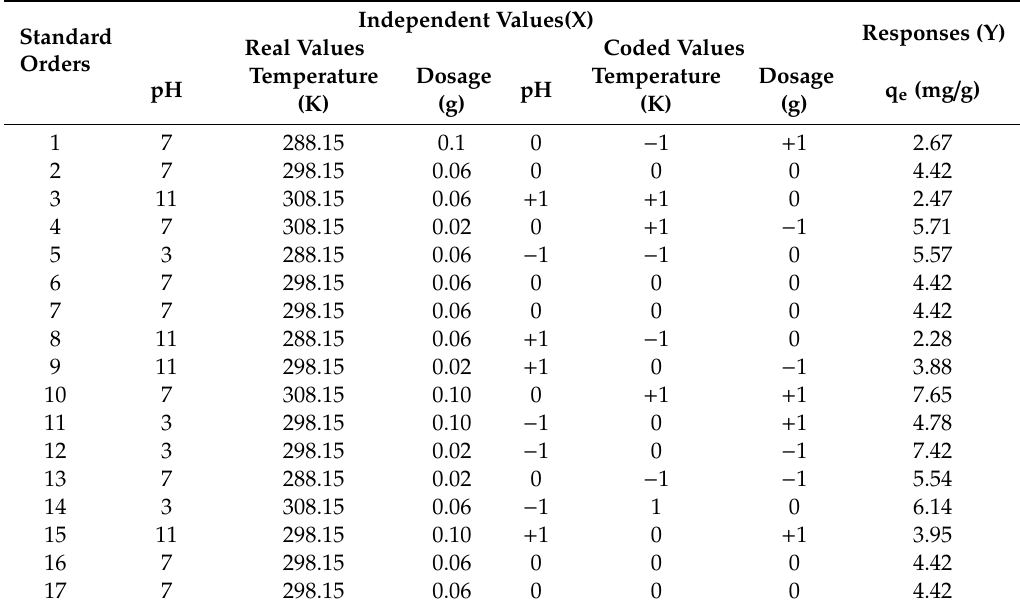
Table 4. Design experiments based on REM and their results.